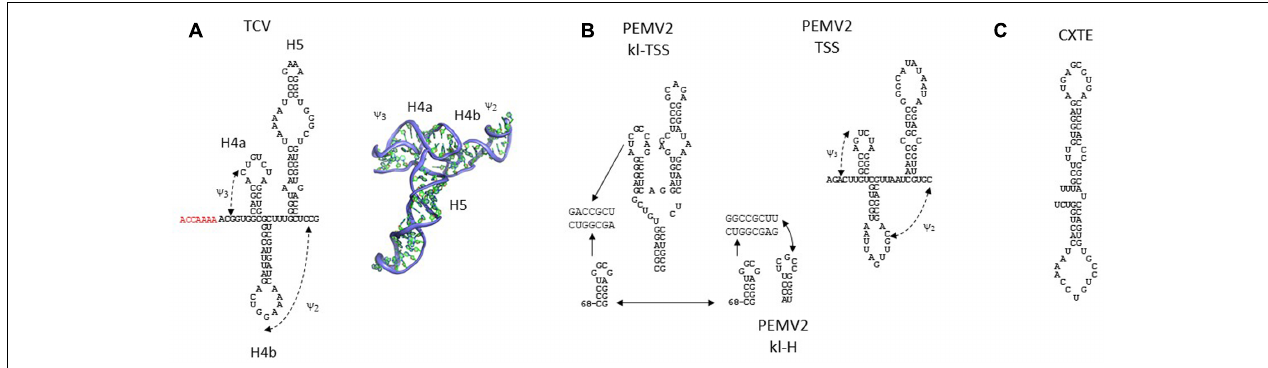
FIGURE 3 | RNA secondary structures of T-shaped 3 (cid:48) -CITEs and CXTE. (A) Assayed two- (McCormack et al., 2008) and three-dimensional structure Zuo et al. (2010) of the TCV TSS, based on data derived from McCormack and Zuo and collegues, respectively. Pseudoknots ( ψ 2 and ψ 3 ) are indicated with a dashed line. Hairpins are H4a/b and H5. Additional nucleotides present in the extended TSS model appear in red (Le et al., 2017). (B) Assayed RNA secondary structures of the two PEMV2 TSS, kl-TSS (Gao et al., 2012, 2013) and TSS (Gao et al., 2014), based on data derived from Gao and colleagues. 5 (cid:48) -end sequence interacting by sequence complementarity with the kl-TSS and with kl-H is shown. (C) Assayed RNA secondary structure of CXTE, the newest 3 (cid:48) -CITE, based on our data derived from Miras et al.